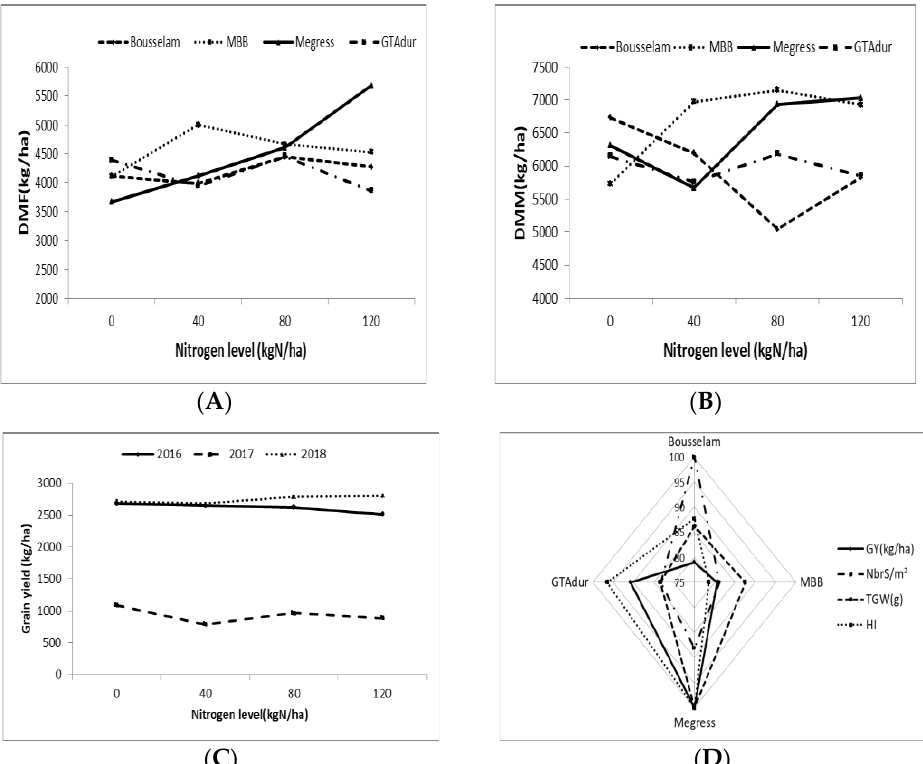
Figure 2. Nitrogen effect on dry matter at flowering ( A ) and maturity ( B ), grain yield ( C ), and genotype grain yield performance ( D ). DMF = Total dry matter at flowering (kg ha − 1 ), DMM = Total dry matter at maturity (kg ha − 1 ), GY = Grain yield (kg ha − 1 ), NbrS m − 2 = Number of spikes m − 2 , TGW = Thousand grain weight (g), HI = Harvest index (%) . Table 4. Means and ANOVA results of dry matter accumulated at flowering and maturity and grain yield and its components.